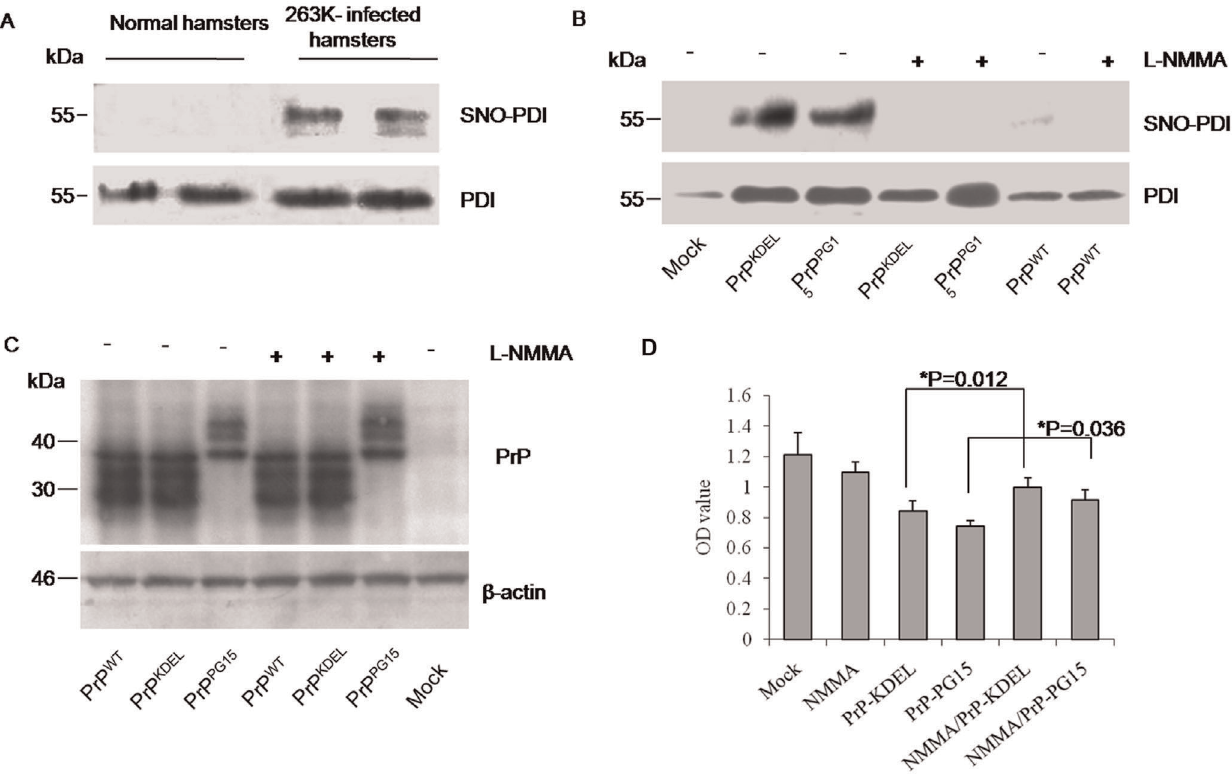
Figure 7. Detections of SNO-PDI in the brains of scrapie infected hamsters and in the cell models of misfolded prion proteins. A. Western blots for the PDI and SNO-PDI signals in hamsters’ brains. The biotinylated and immunoprecipitated by streptavidin-agarose beads proteins from brain homogenates of 263K infected or normal hamsters were separated in 15% SDS-PAGE and blotted with respective specific antibodies. B. Western blots for the PDI and SNO-PDI signals in the cell models in the presence ( + ) or absence (-) of L-NMMA. All cells were maintained for 48 h after transfection and then treated with 1 nM L-NMMA for 6 h. C. Evaluation of the influence of L-NMMA on the expressions of various PrP constructs by Western blots. Cell lysates were separated in 15% SDS-PAGE and blotted with respective antibodies. D. Cell viability. The results are calculated from three independent tests indicated as mean 6 SD. Statistical differences compared with controls are illustrated as *P , 0.05.